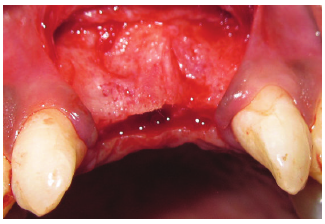
Figure 1: After reflection of flap.